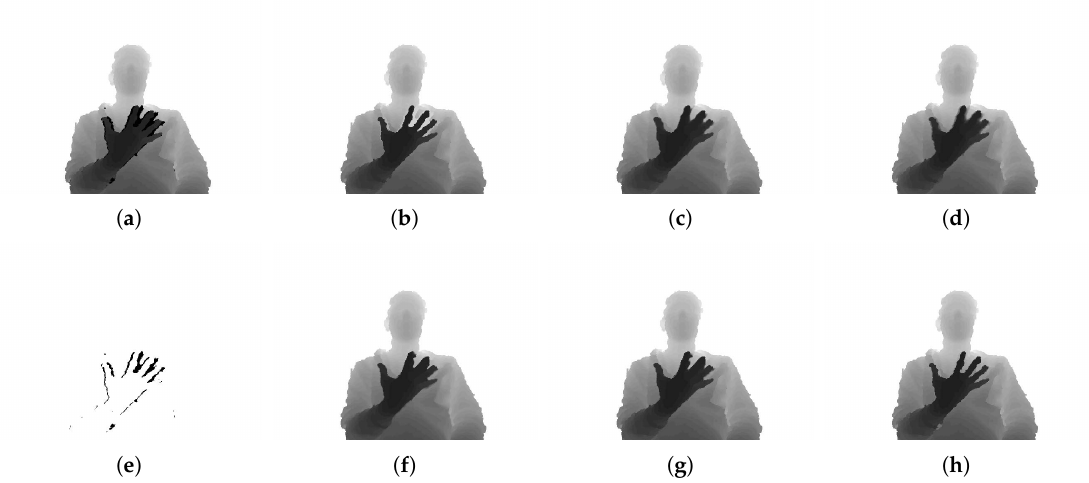
Figure 11. ( a , e ) are the segmented depth regions and masking region indicating inner depth holes, respectively; The others show the experimental results of the inner hole filling methods; ( b ) method based on [58]; ( c ) method in [59]; ( d ) method in [34]; ( f ) method in [26]; ( g ) method in [33]; ( h ) proposed method. (The contrast of the depth images has been adjusted for